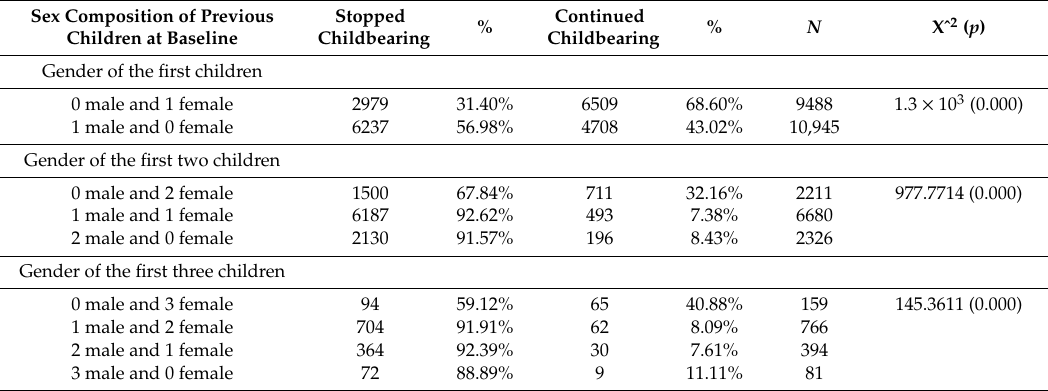
Table 4. Baseline sex composition on subsequent childbearing ( N =